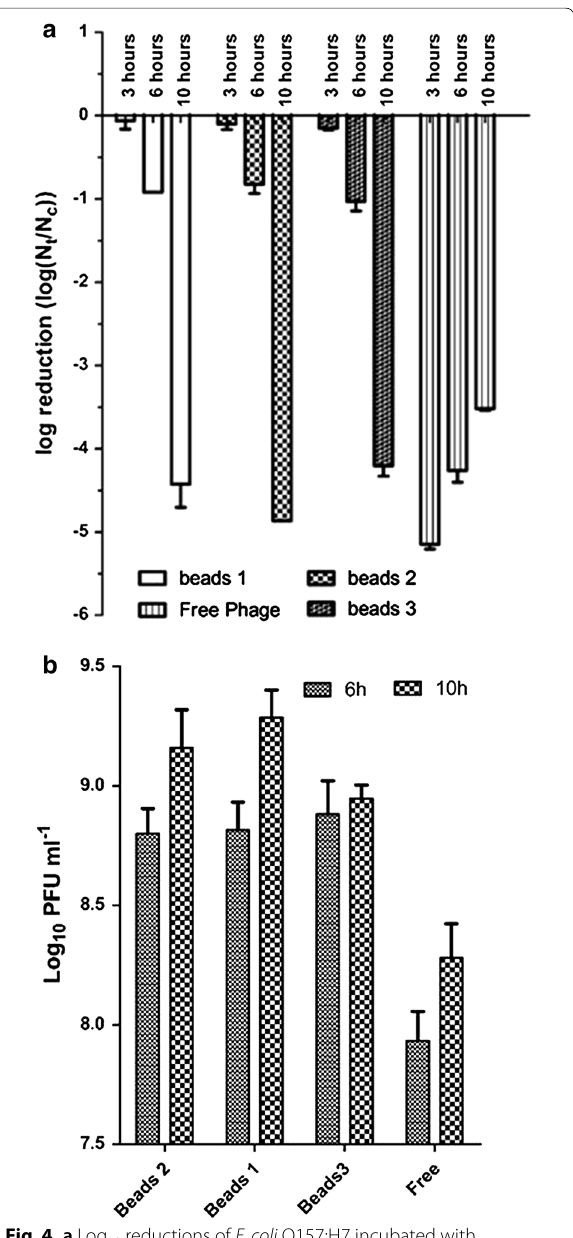
Fig. 4 a Log 10 reductions of E. coli O157:H7 incubated with encapsulated and non‑encapsulated bacteriophages in gastrointestinal fluid at 37 °C for 6 h and 10 h. Nt stands for the number of E. coli O157:H7 after treatment with encapsulated and non‑encapsulated bacteriophages at MOI 1 and Nc represents the = number of E. coli O157:H7 at the control state. All phage treatments produced significant falls in the viable count of E. coli O157:H7 ( p value < 0.01). b Bacteriophage titers (Log 10 PFU) of non‑capsulated and encapsulated phages after infecting E. coli O157:H7 at MOI 1 in = gastrointestinal fluid for 6 h and 10